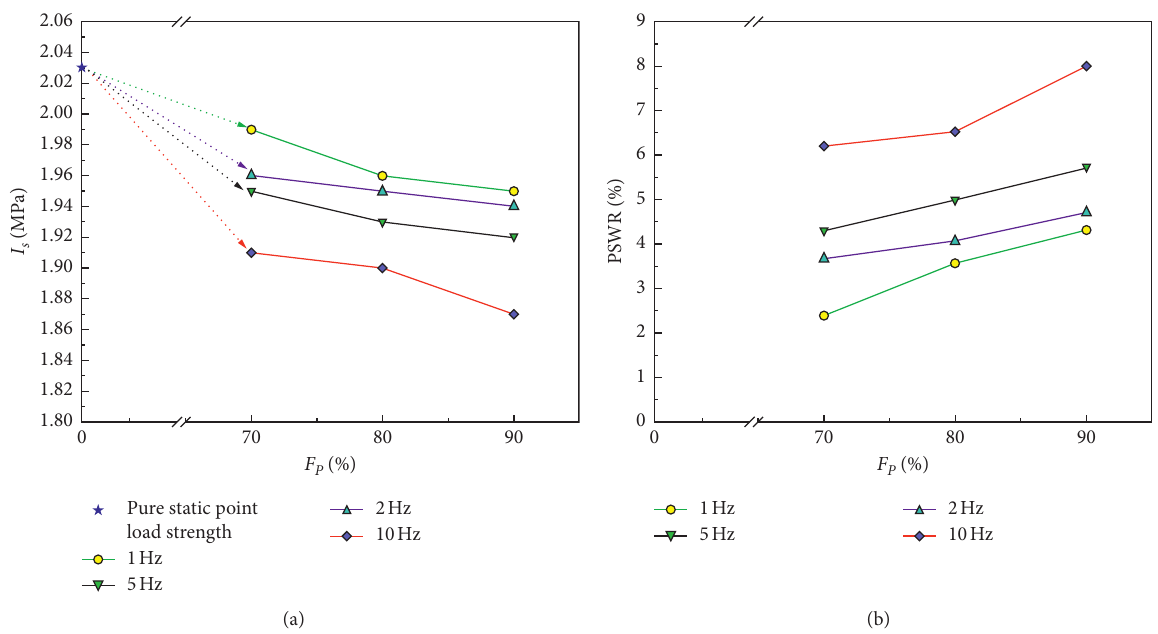
Figure 9: The point load strength and the corresponding weakening rate change trend with the prestatic load level. (a) Point load strength. (b)